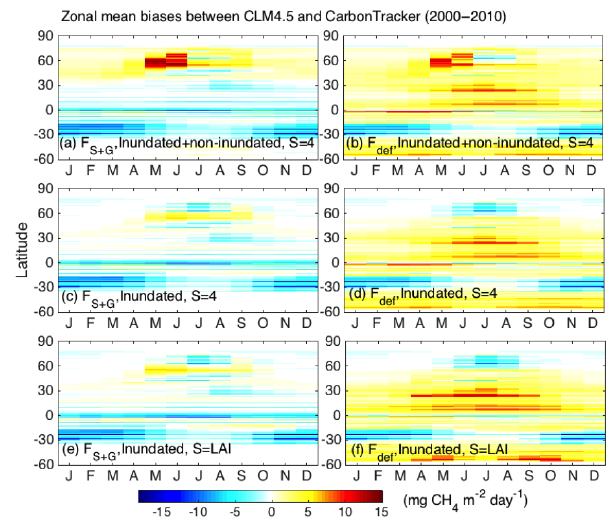
Figure 1. Zonal mean biases of CH 4 emissions between CLM4.5 predictions and CarbonTracker (CH 4 _CLM4.5- CH 4 _CarbonTracker) with SWAMPS-GLWD ( F S + G ) and CLM4.5 predicted ( F def ) inundation fraction: CLM4.5 predictions of both inundated and non-inundated emissions with F S + G (a) and F def (b) , while aerenchyma area is corrected with S = 4; CLM4.5 predictions of inundated emissions only with F S + G (c) and F def (d) , while aerenchyma area is corrected with S = 4; CLM4.5 predictions of inundated emissions only with F S + G (e) and F def (f) , while aerenchyma area is parameterized by default S =